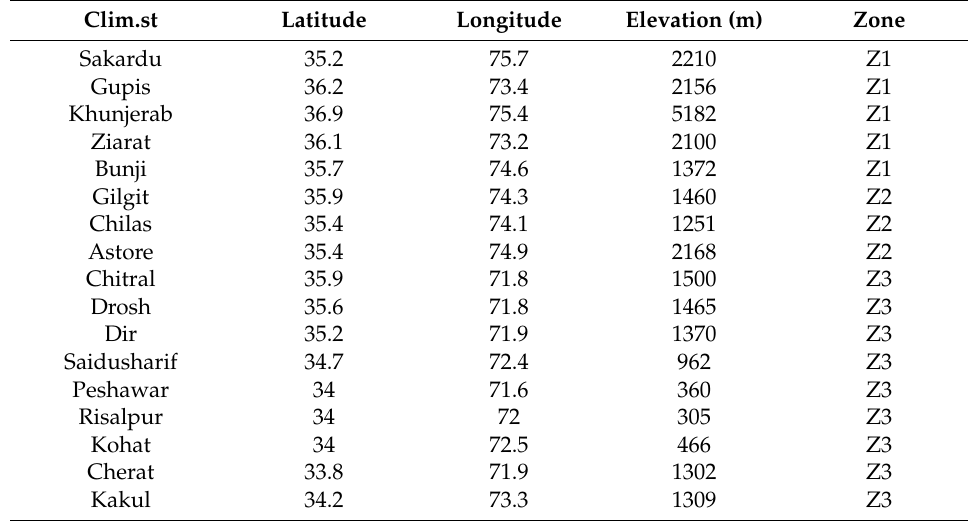
Table 2. Climate stations in